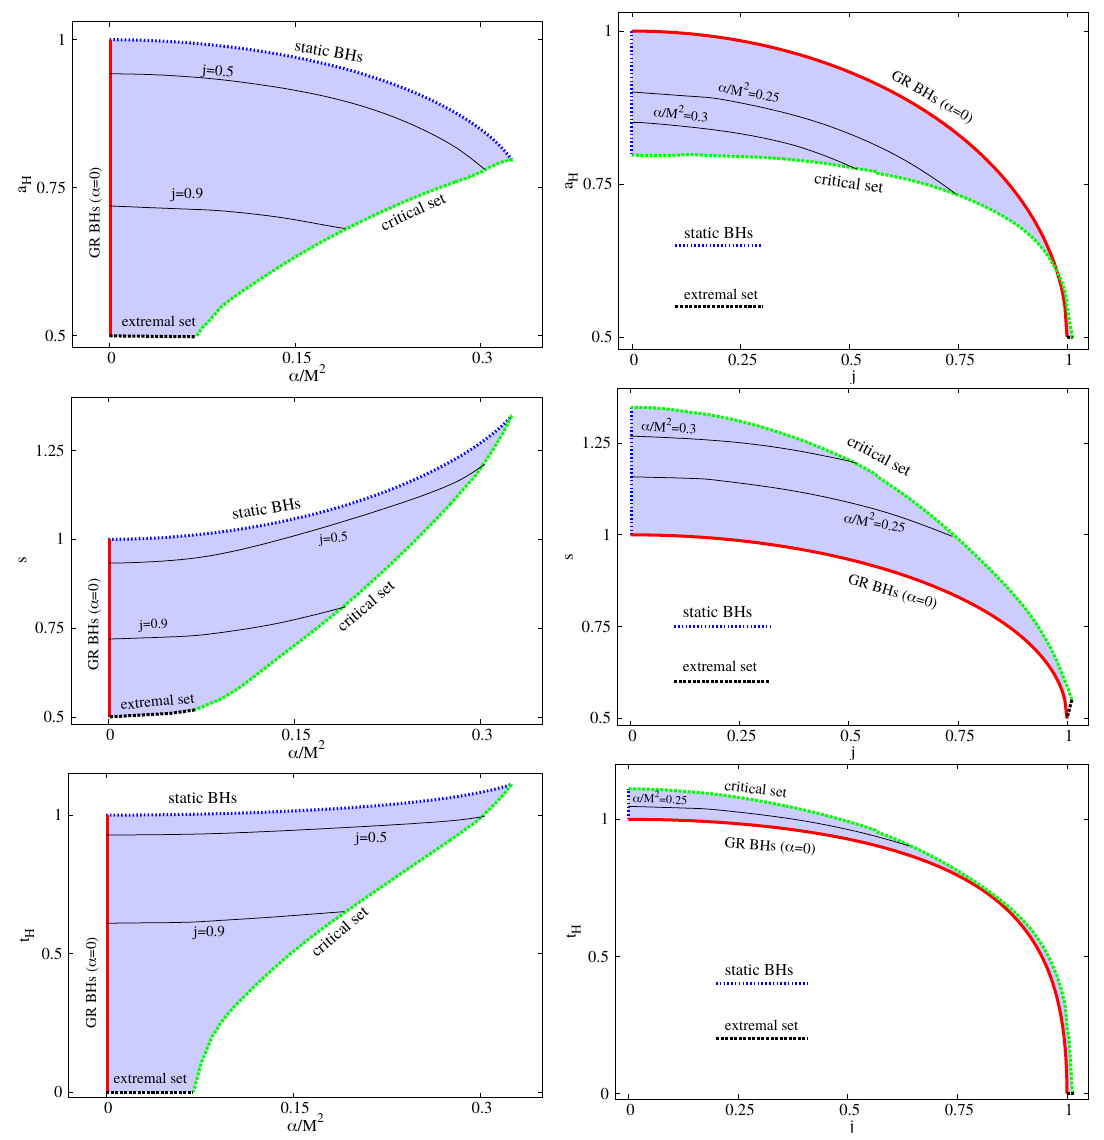
Figure 4 . Domain of existence of spinning EsGB BHs in a reduced horizon area (top panels), entropy (middle panels) and Hawking temperature (bottom panels) vs. the dimensioness coupling (cid:11)=M 2 (left panels) or angular momentum j (right